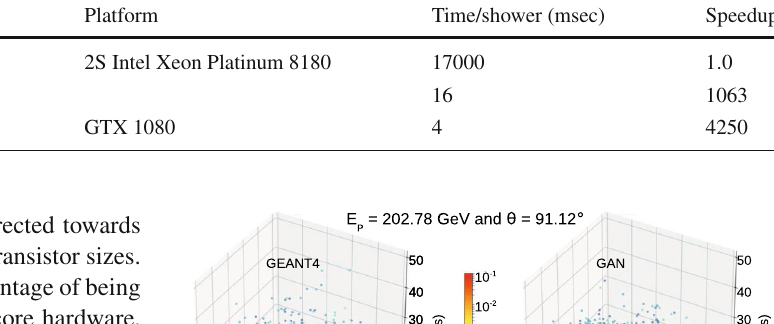
Fig. 5 The L G losses for the generator (blue) and the discriminator (orange) converge for the first training step with restricted E P range. (Left) training losses. (Middle) test losses. (Right) the discriminator output O GAN for MC (red) and GAN (blue) images is similar and the discriminator is confused Table 2 Inference timing for